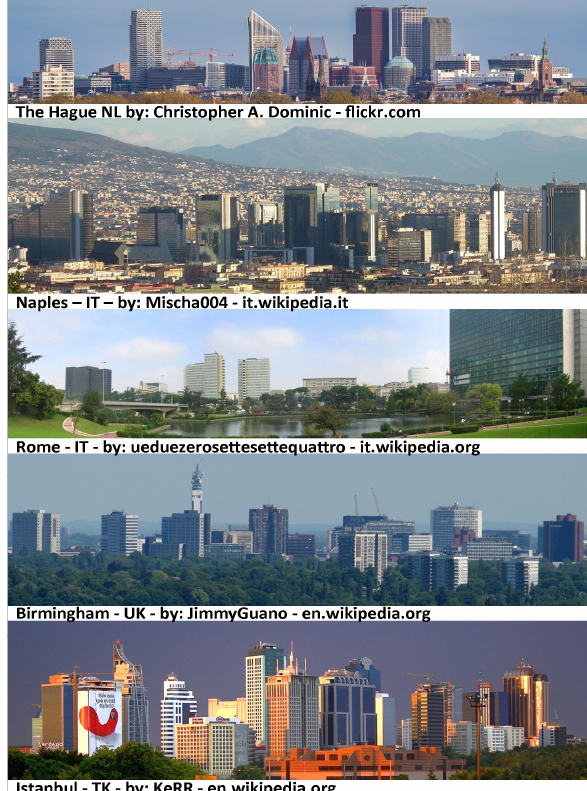
Figure 3. Comparison of cityscapes of European cities affected by location of tall buildings, by: author